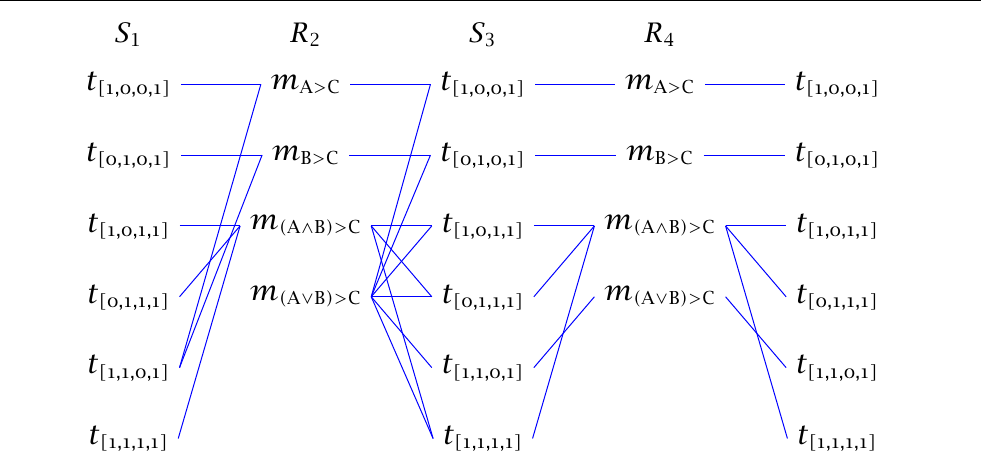
Figure 13 Predictions for sda -disjunctions with conjunctive